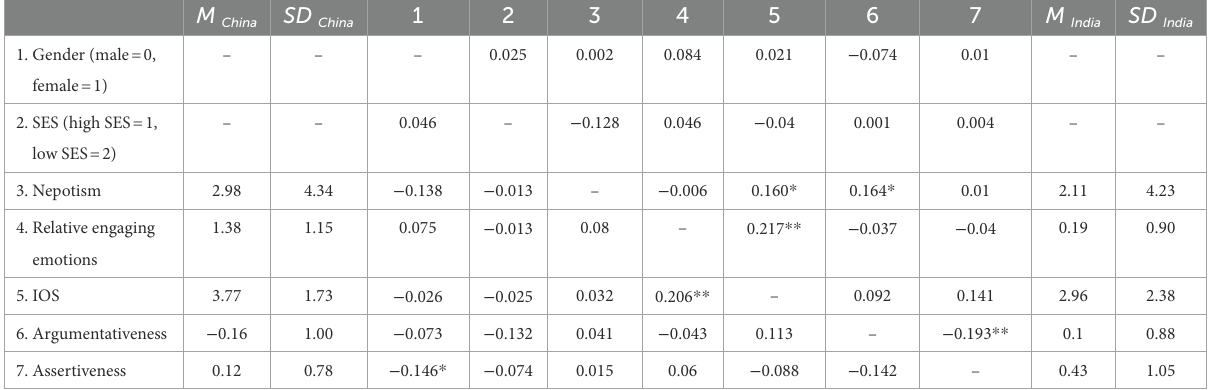
TABLE 3 Descriptive statistics and the internal correlations among the variables for Chinese (below the diagonal) and Indians (above the diagonal). M